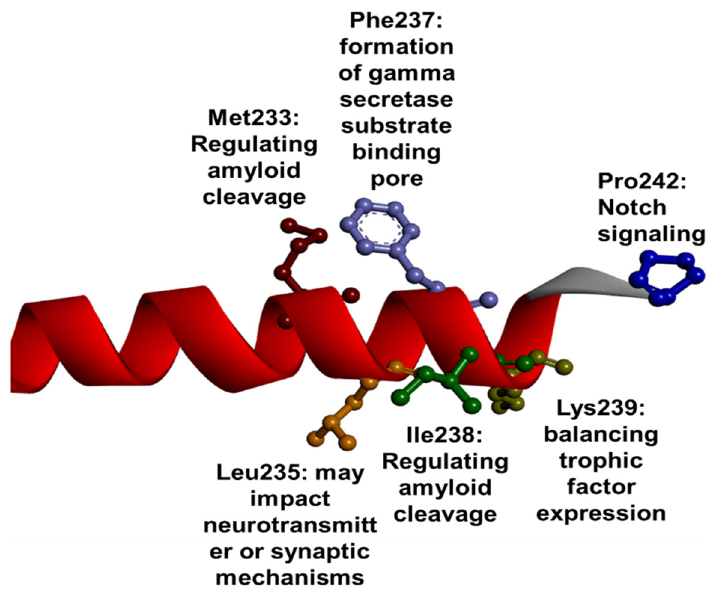
Figure 8 . Significant residues in TM5 and HL5 . Figure 8. Significant residues in TM5 and